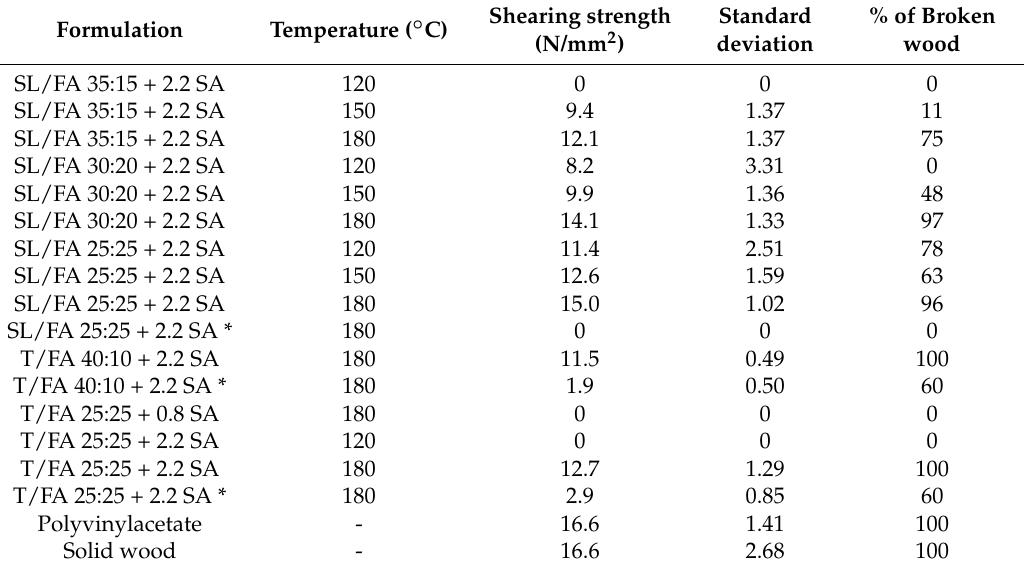
Table 4. Solid wood gluing: Shearing test results listed according to formulation and curing condition.